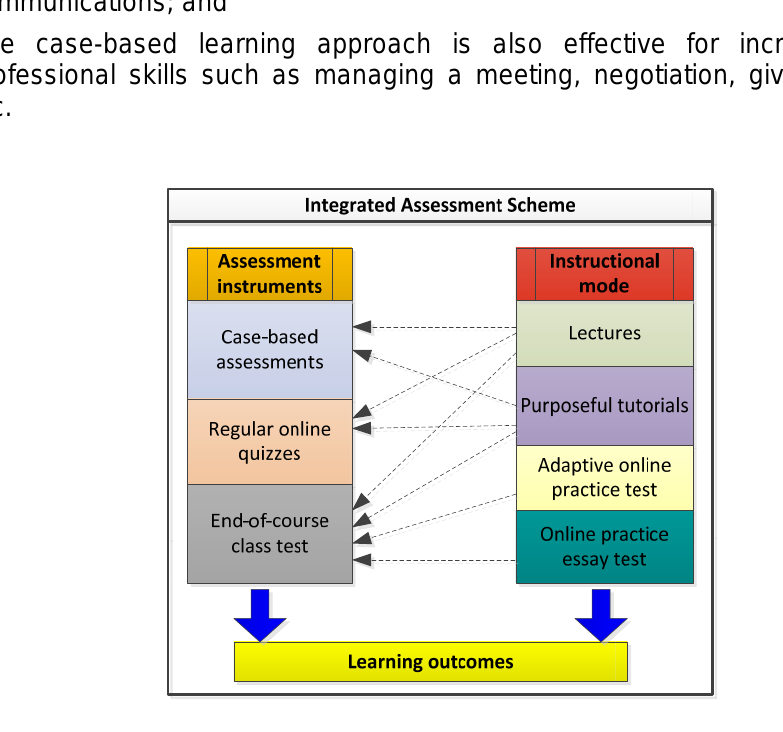
Figure 1: Integrated assessment